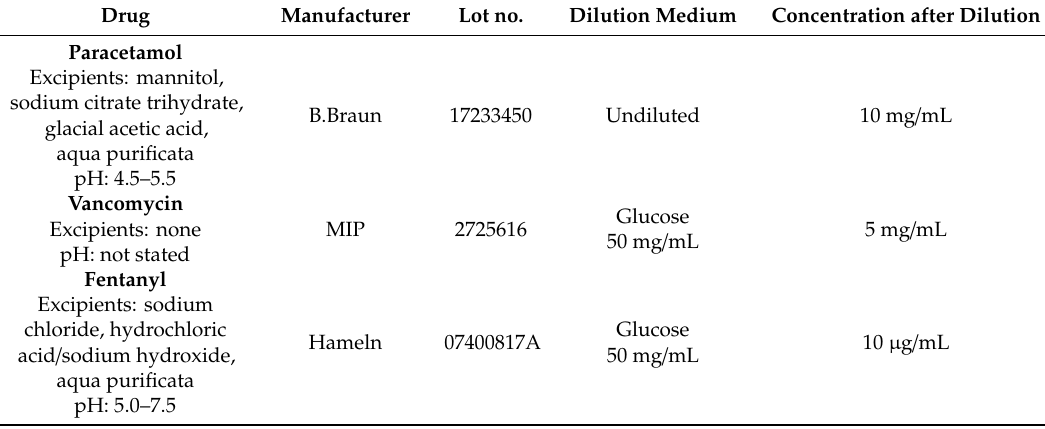
Table 2. Overview of drug formulations, dilution media, and their final